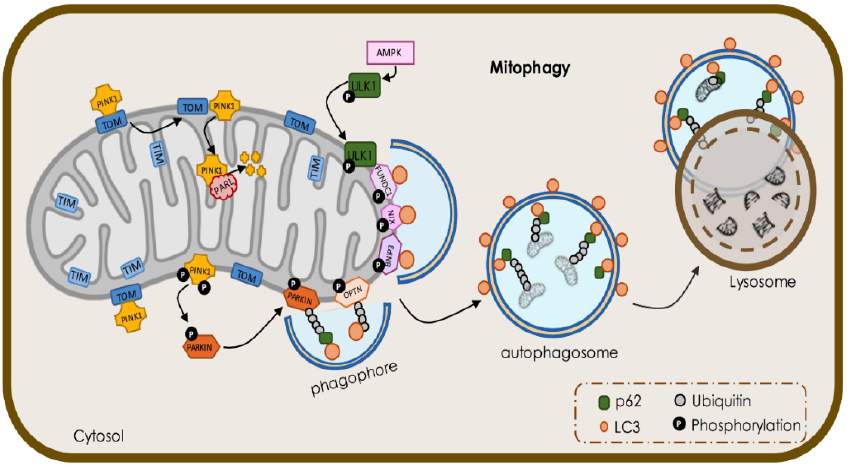
Figure 3. Overview of mitophagy machinery. Dysfunctional mitochondria stabilize PTEN-induced kinase 1 (PINK1) in the outer mitochondrial membrane (OMM) while its proteolytic cleavage through presenilin-associated rhomboid-like (PARL) proteases is blocked. Concurrently, PINK1 recruits Parkin through a series of modifications, including the phosphorylation of both Parkin and ubiq- uitin. Polyubiquitinated proteins are recognized by several adaptor molecules, including p62 and optineurin (OPTN), anchoring mitochondria to nascent phagophore through microtubule associated light chain 3 (LC3) binding. Receptor-mediated mitophagy relies on various OMM proteins, such as BCL2 Interacting Protein 3 (BNIP3), BNIP3-like protein X (NIX), and FUN14 domain-containing protein 1 (FUNDC1). After elongation is complete, the autophagosome fuses with lysosome for degradation of dysfunctional